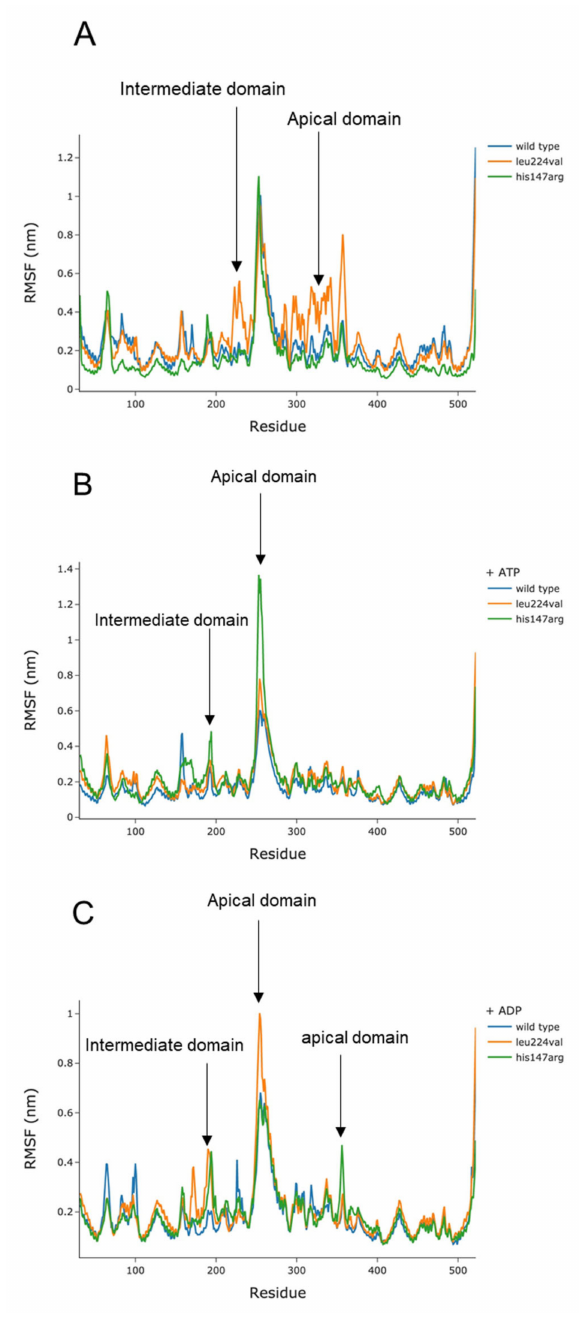
Figure 2. Root-mean-square fluctuation (RMSF) analysis of the amino acids of CCT5 wild- type subunit (blue line), and the His147Arg (green line) and Leu224Val (orange line) mutants. ( A , B , C ): nucleotide-free, ATP-bound, and ADP-bound conditions, respectively. The images show that the residues corresponding to the apical (amino acids 227 to 378) and intermediate (amino acids 155 to 226 and 381 to 417) domains of both CCT5 variants fluctuate more than wild-type residues under all three conditions. The apical and intermediate domains of the Leu224Val mutant display the greatest dynamism in the absence of nucleotide and in the presence of ADP ( A , C ). The apical and intermediate domains of the His147Arg mutant show the highest dynamism in the presence of ATP ( B ). The equatorial domains of the two CCT5 variants, in all three conditions, remain similar to the equatorial domain of the wild-type molecule. See Supplementary Materials, Video